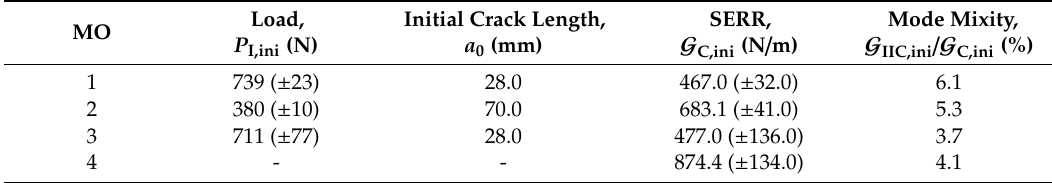
Table 4. Total strain energy release rate (SERR) ( G C,ini ) and mode mixity ( G IIC,ini / G C,ini ) values of the double cantilever beam (DCB) tests for the four manufacturing options (MOs). Load, Initial Crack Length, MO P I,ini (N) a 0